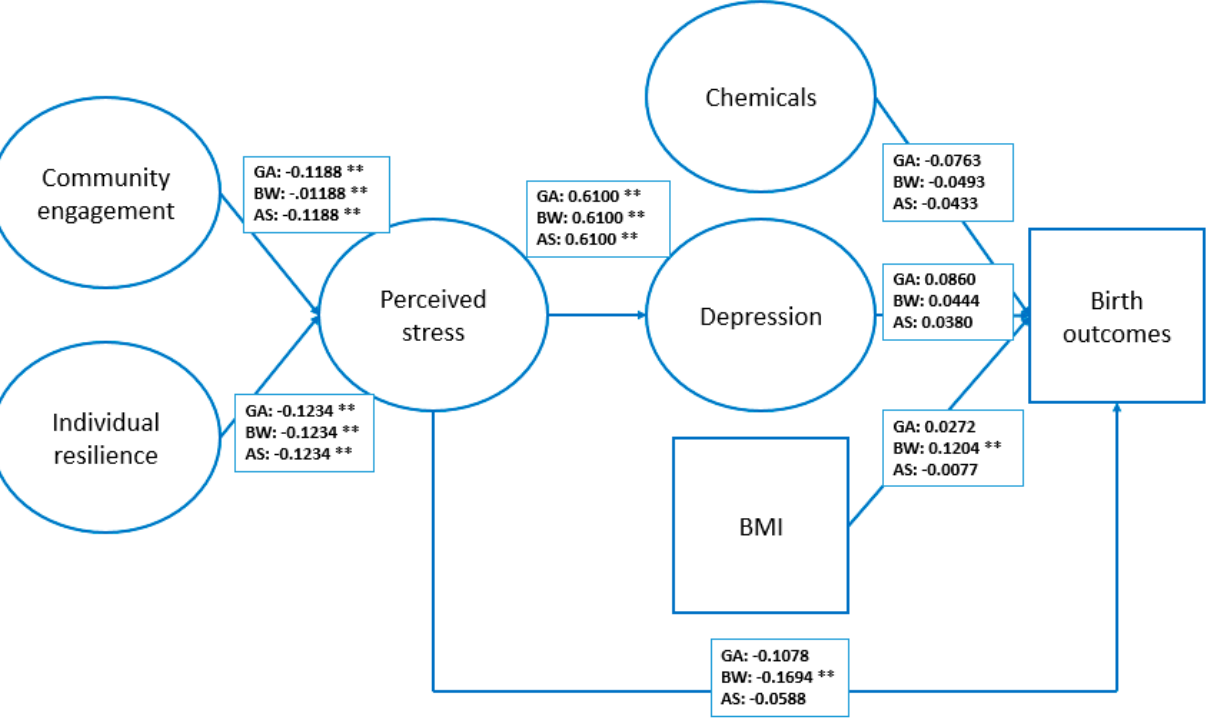
Figure 1. Path model of relationships among non-chemical stressors, the latent chemical construct, and birth outcomes. GA: gestational age model; BW: birthweight model; AS: Apgar score model. ** Significant at <0.05 level. Circle implies latent construct and square implies manifest variable.